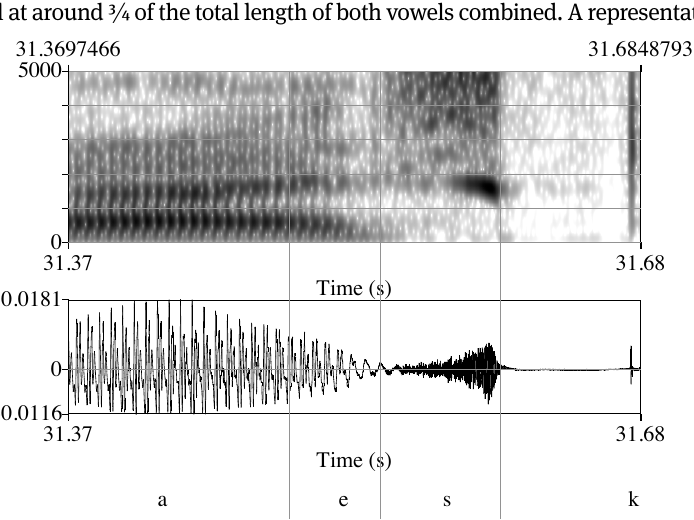
Figure 3 . Measurement of English stimuli with vowel prothesis after a vowel (Sar[a esk]ewers).